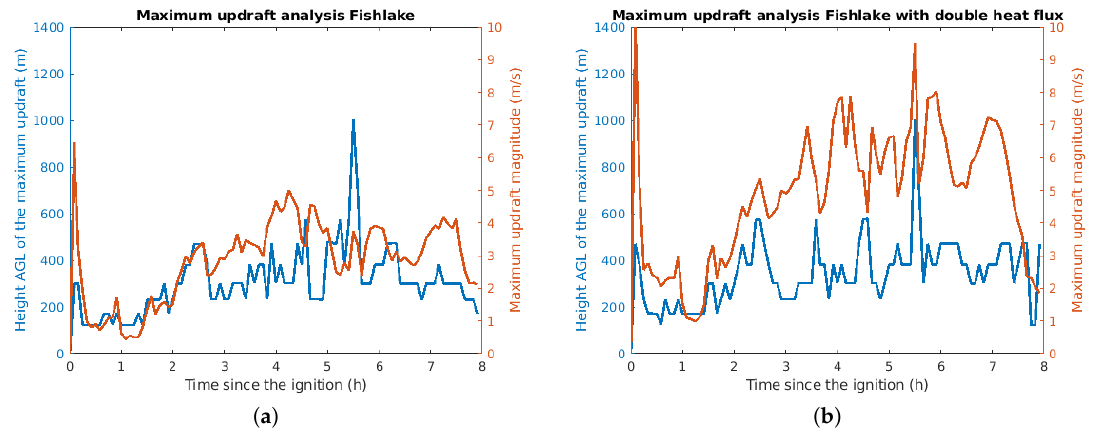
Figure 6. Time series of the maximum updraft strength and location from the Fishlake simulation for 09/03/2014. ( a ) Standard simulation; ( b ) Simulation with doubled fire heat flux released to the